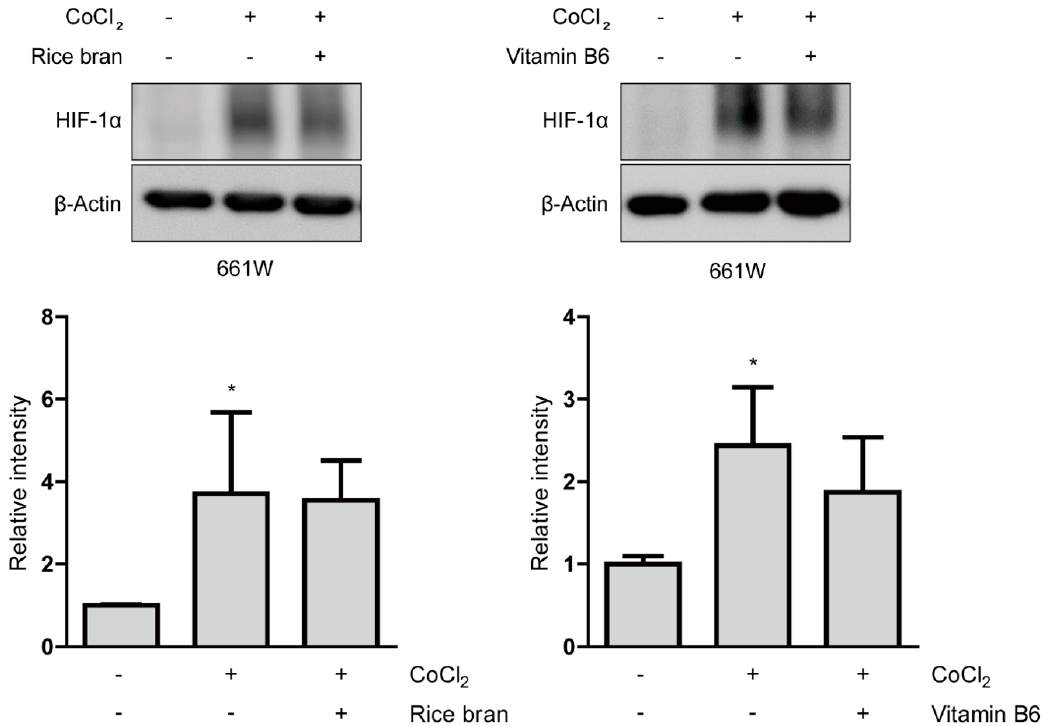
Figure A4. No effect of rice bran and vitamin B6 on HIF ‐ 1 α stabilization. Representative immunoblot images and quantitative analyses (n = 4 per group) for HIF ‐ 1 α and β‐ Actin showed that HIF ‐ 1 α was stabilized in 661W cells under a CoCl 2 ‐ induced pseudo ‐ hypoxic condition. 1 mg/mL of rice bran and vitamin B6 did not significantly decrease stabilized HIF ‐ 1 α expression. * p < 0.05, compared with no treatment. Bar graphs were presented as mean ± standard deviation. The data were analyzed using one ‐ way ANOVA followed by a Bonferroni post hoc test. Solvents, rice bran: DMSO; vitamin B6: water.